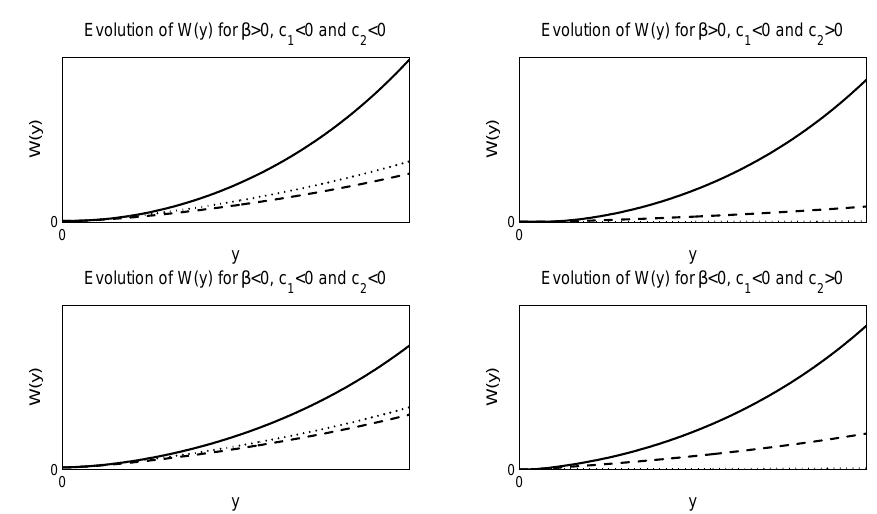
Figure 2. Evolution of the solution Equation (50) of the Heston model. For the numerical solutions, we select ρ = 0.5, β = | 0.7 | , r = 0.5, κ 1 = 1 and κ 2 = 1.01. The left figures are for negative c 1 , c 2 , while the right figures are for negative c 1 and positive c 2 . The solid lines are for | c 2 | = 3 | c | , and the dash-dash lines are for | c are for | c 2 | = 2 1 3 lower figures for β <